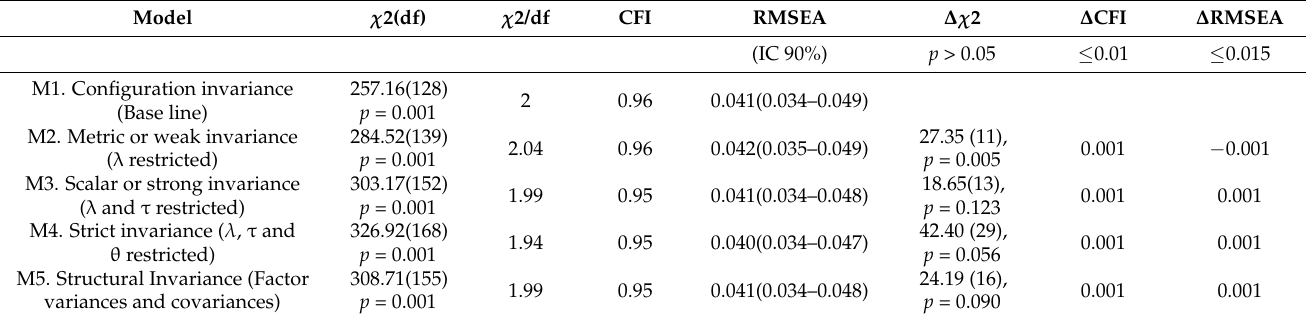
Table A5. Analysis of the factorial invariances for the boys